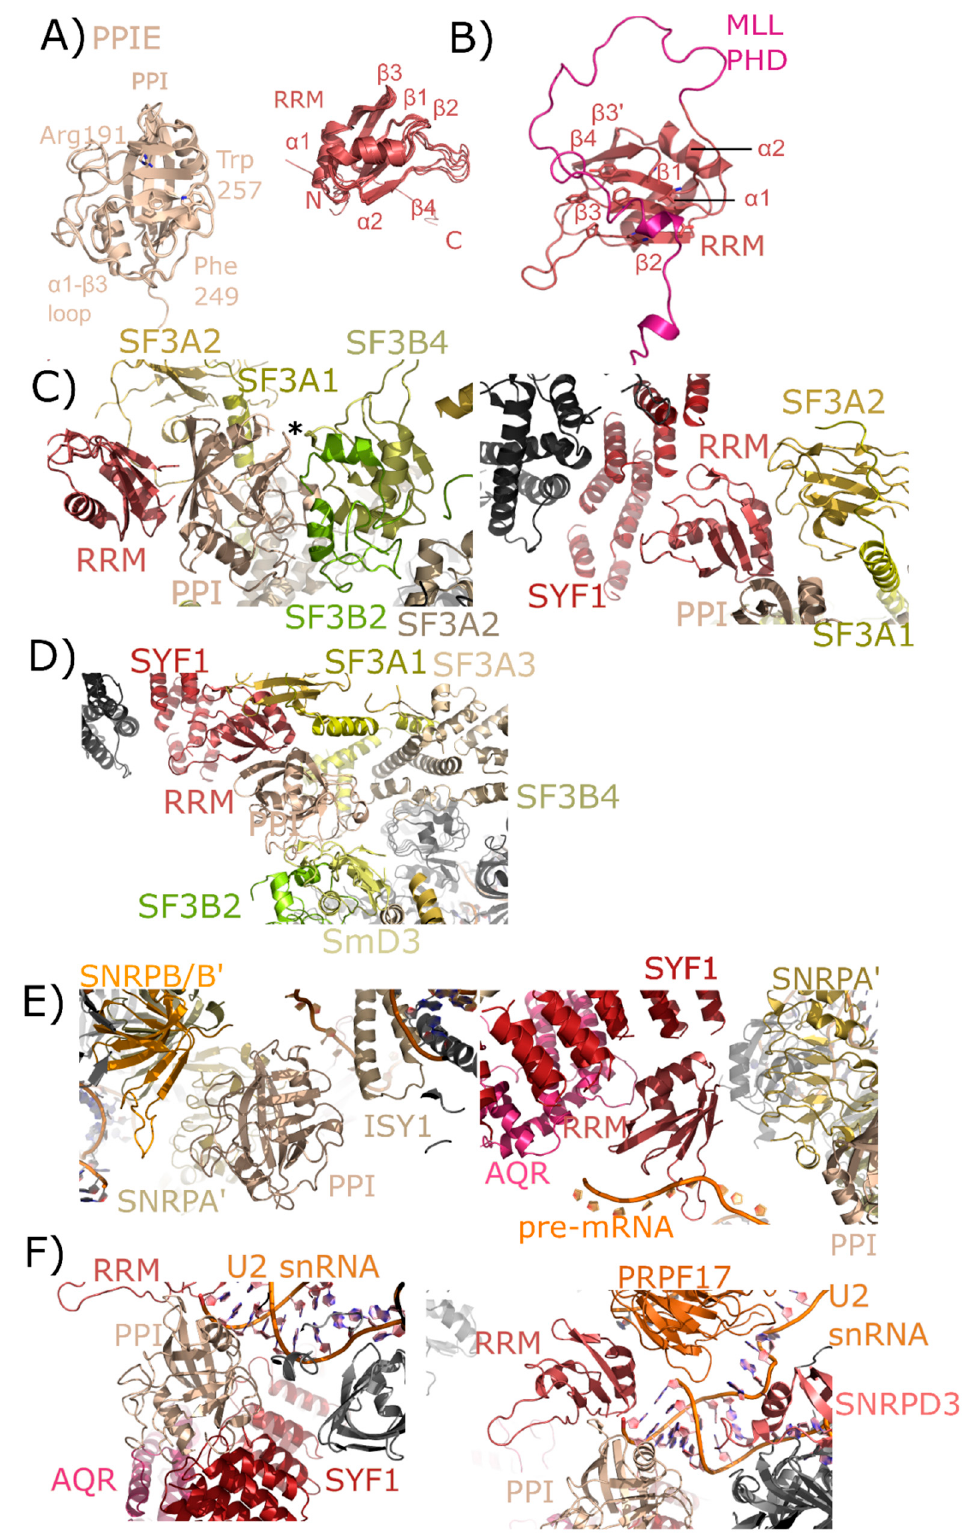
Figure 5. Structures of PPIE in solution and in spliceosomes. In ( A ), the cyclophilin and RRM domains of PPIE are shown in cartoon representation. The isomerase domain is represented by an overlay of PDB IDs: 2R99, 1ZMF, and 3UCH. Selected catalytic residues and protein–protein interaction regions are labeled. The RRM domain is represented by an overlay of PDB IDs: 2CQB, 2KU7, 2KYX, 3LPY,